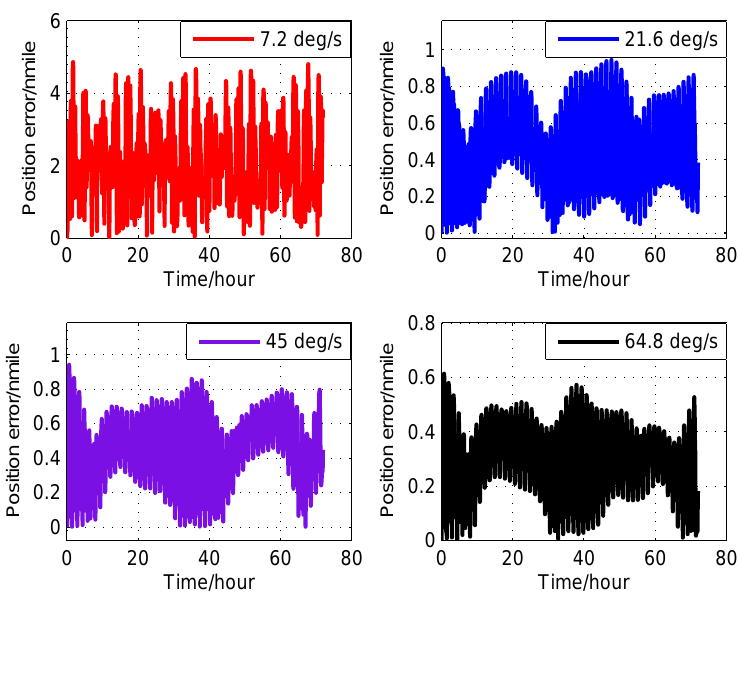
Figure 10. Simulation results of Group 2.